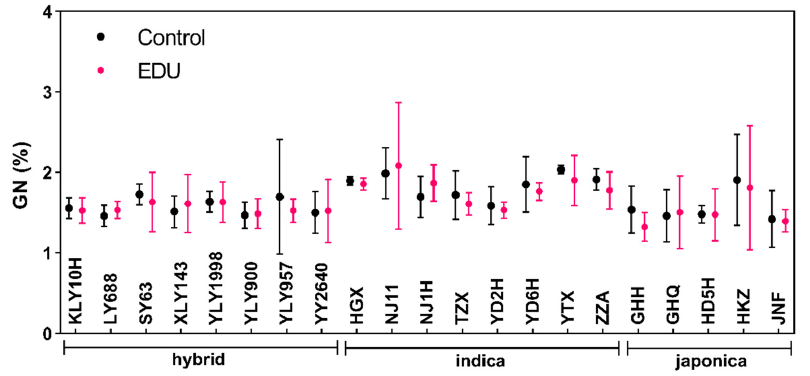
Figure 1. Grain nitrogen concentration (GN, %) in rice cultivars. The mean (circle) and 95% confidence interval (short horizontal lines connected with a vertical line) are shown for comparison between EDU and control treatments. Table 2. ANOVA results for the grain nitrogen, grain carbon, grain protein, nitrogen yield, carbon yield and protein yield in three types of rice cultivars: hybrid, indica and